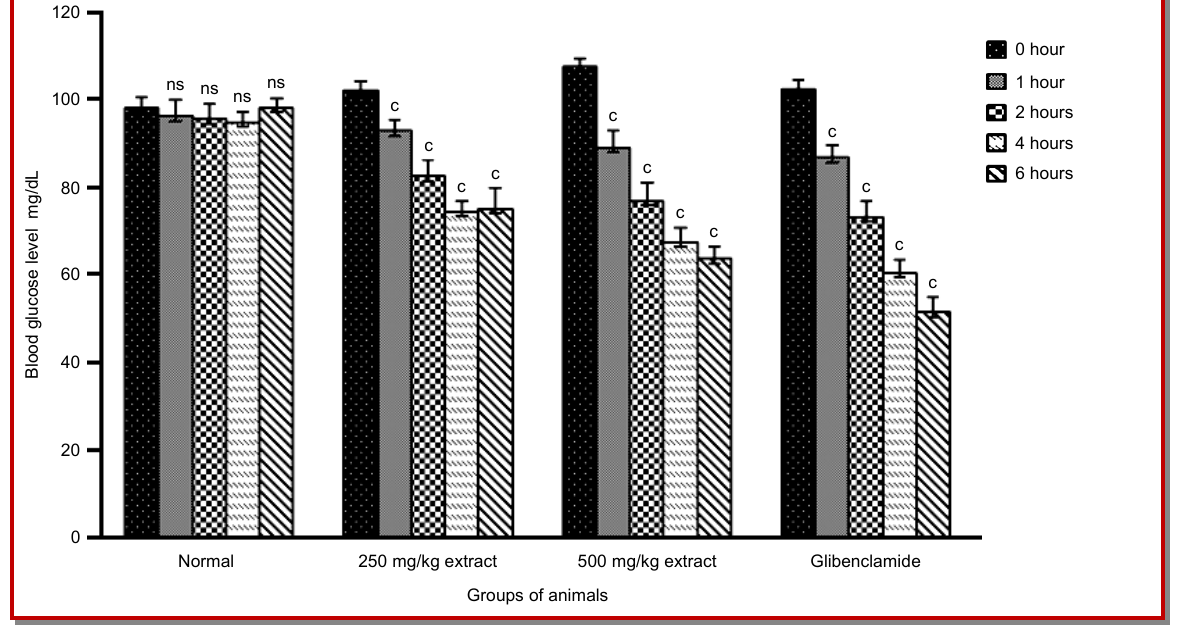
Figure 1: Evaluation of crude powder of Teucrium stocksianum for hypoglycemic activity in normoglycemic rabbits. (n = 6) where, ns = Non-significant change; cp<0.001